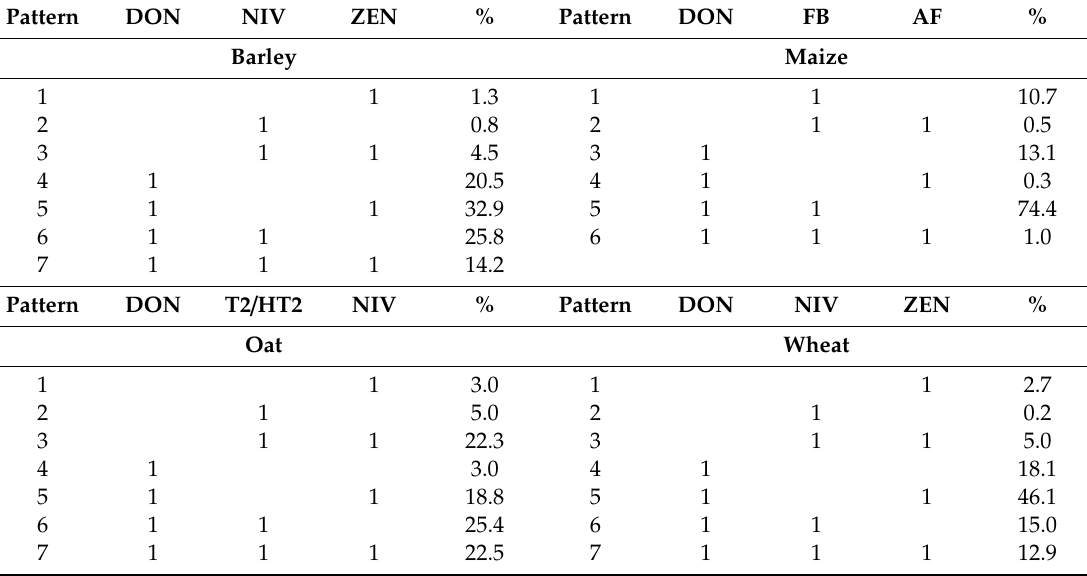
Table 3. Probability simulated by the multinomial model of having co-occurring mycotoxins in maize, barley, oat, and wheat.